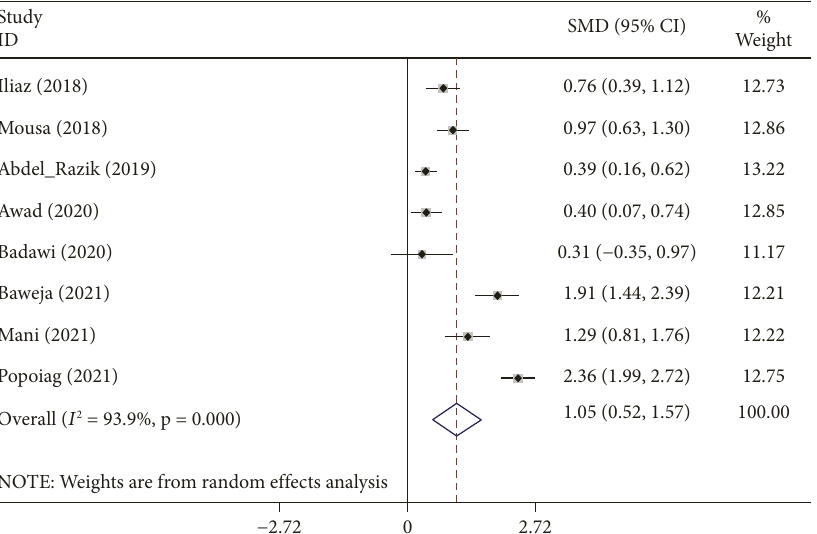
Figure 4: Meta-analysis of differences in the NLR level between cirrhotic patients with ascites who developed SBP had elevated levels of NLR compared to those who did